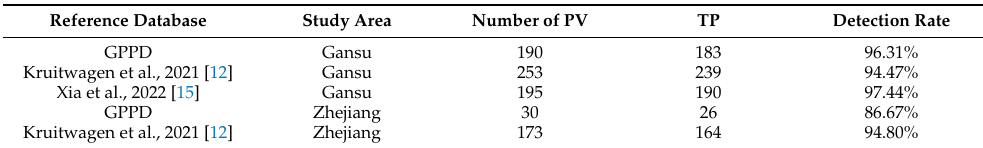
Table 7. Consistency of our detection with existing PV database.